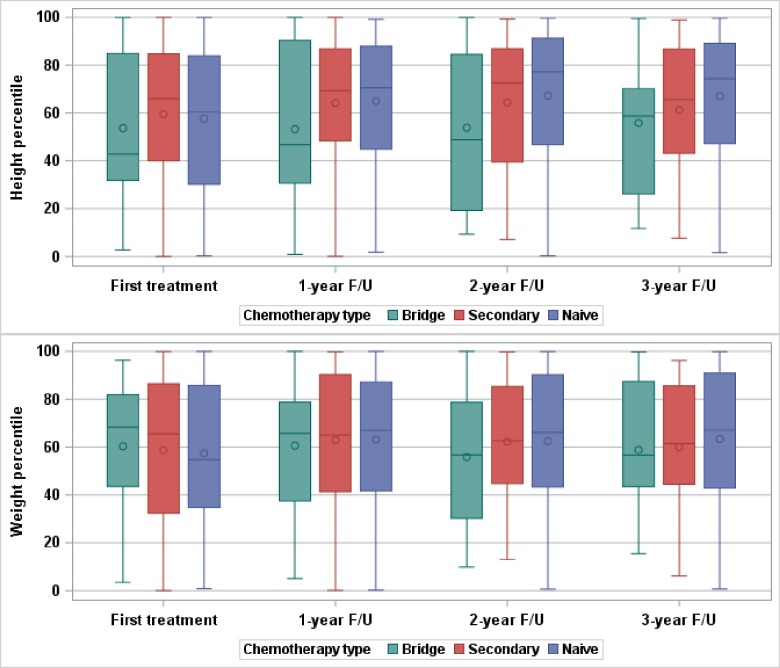
Height and weight percentiles at first treatment, 1, 2 and 3 year follow-up by chemotherapy group.Mean height percentiles are not significantly different by group at first treatment (ANOVA p = 0.72, n = 291), 1 year (p = 0.14, n = 276), 2 year (p = 0.06, n = 203) and 3 year (p = 0.49, n = 134) follow-up. Mean weight percentiles are also not significantly different by group at first treatment (p = 0.86, n = 334), 1 year (p = 0.93, n = 290), 2 year (p = 0.65, n = 209) and 3 year (p = 0.73, n = 137) follow-up.